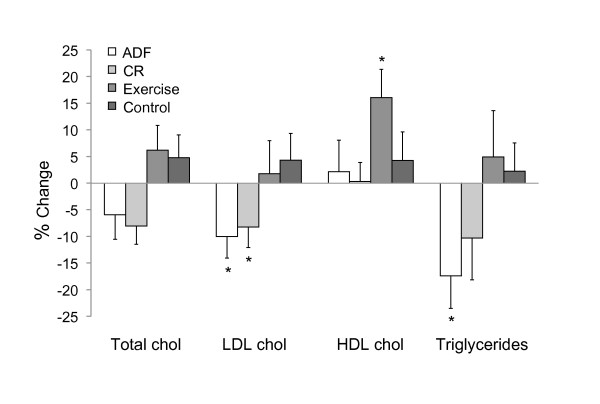
Change in plasma lipid concentrations after 12 weeks of treatment. Values reported as mean ± SEM. Alternate day fasting (ADF), n = 13; Calorie restriction (CR), n = 12; Exercise, n = 12; Control, n = 12. *Significantly different between groups, P <0.05 (One-way ANOVA).